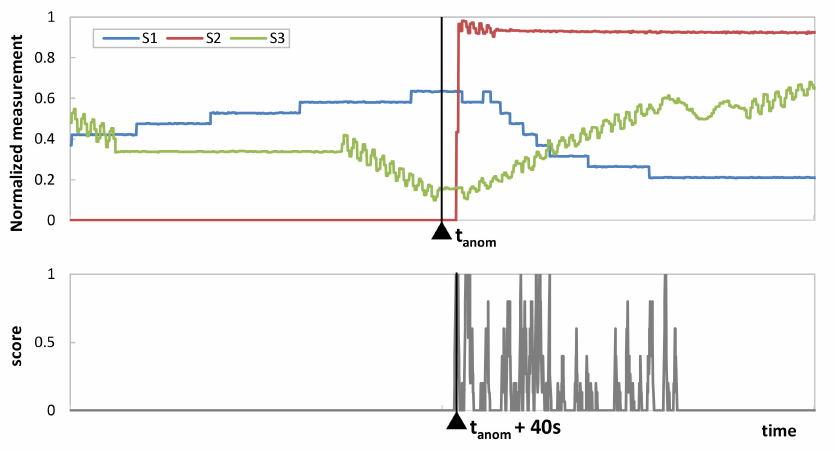
Figure 9. MS-AGD